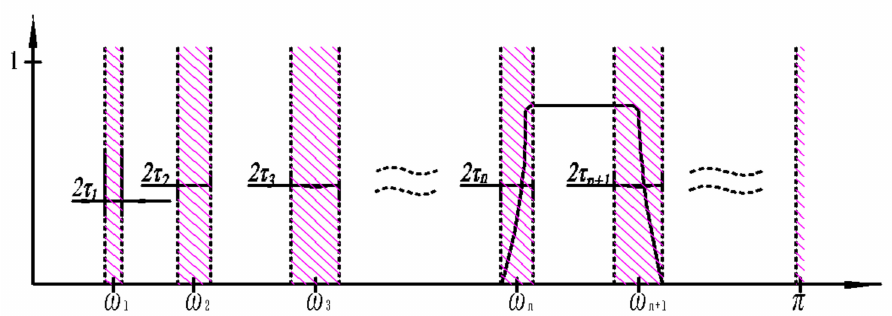
Figure 2. Segmenting Fourier spectrum into N contiguous